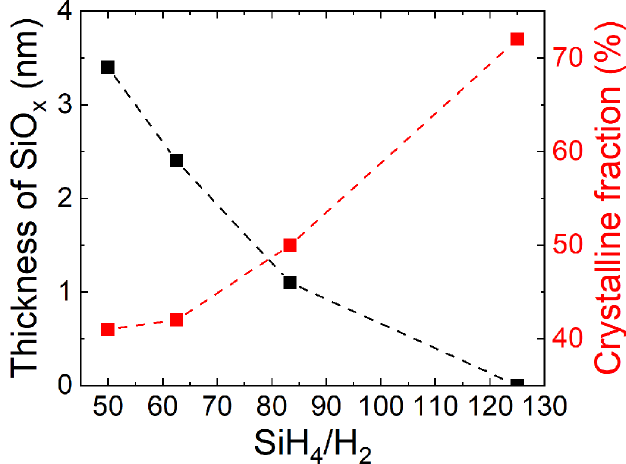
Fig. 2. Evolution of crystalline fraction in the PECVD silicon layer, and fi tted silicon oxide thickness with the SiH 4 /H 2 fl ow rate ratio on Batch 1 samples before fi ring step . Nominal SiO x thickness is 2.2nm.